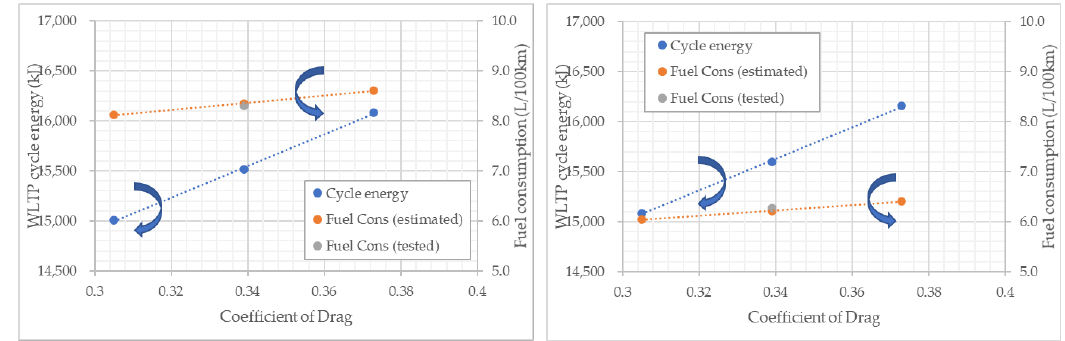
Figure 22. Effect of the aerodynamic drag (drag coefficient) on the cycle energy and fuel consumption Figure 22. E ff ect of the aerodynamic drag (drag coe ffi cient) on the cycle energy and fuel consumption in WLTP (left/right: gasoline/diesel). in WLTP (left / right: gasoline / diesel).